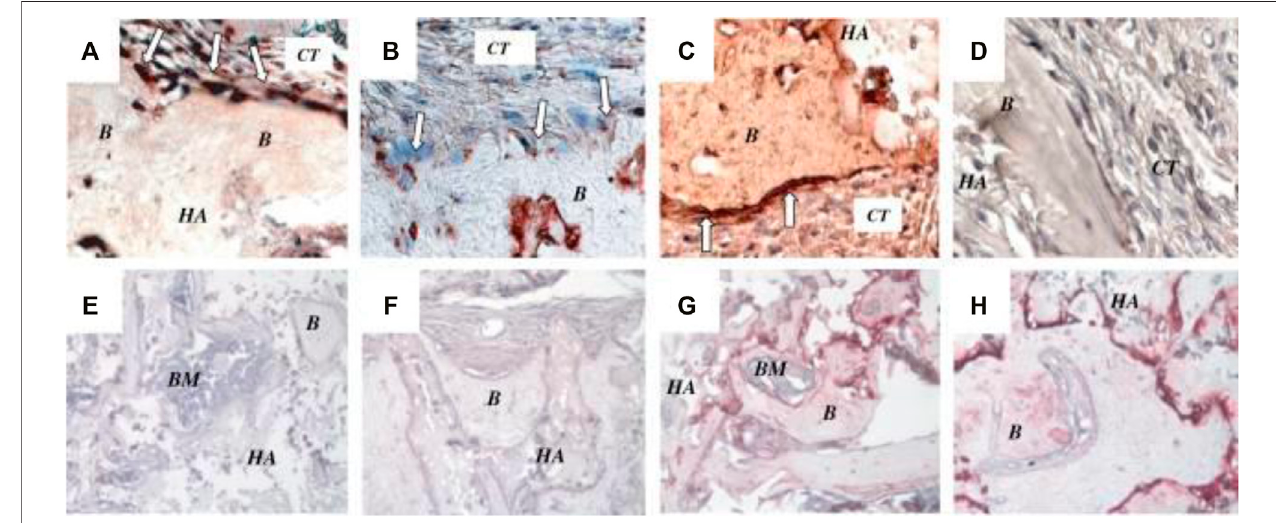
FIGURE 2 | In vivo characterization of SHED. (A) After 8 weeks transplantation in immunocompromised mice, SHED were able to form bone (B) on the surface of hydroxyapatite/tricalciumphosphate(HA).Osteogeniccellswerepositiveforanti-ALP(openarrowsin A ),BSP(openarrowsin B )andtypeIcollagen(openarrows)in (C) antibody staining revealed osteogenic cells. BSP and type I collagen stain positively on connective tissue (CT) cells. (D) Immunohistochemical staining of SHED transplants with preimmune serum as a negative control. DSP was not expressed as an odontogenic marker in bone marrow mesenchymal SCs (E) or SHED (F) . BSPexpression was positive in bone marrow mesenchymal SC-mediated bone (G) aswell asbone marrow SHED-mediated bone (g) (H) . BM stands for bone marrow, HA for HA/TCP. Reproduced with permission from (Seo et al.,